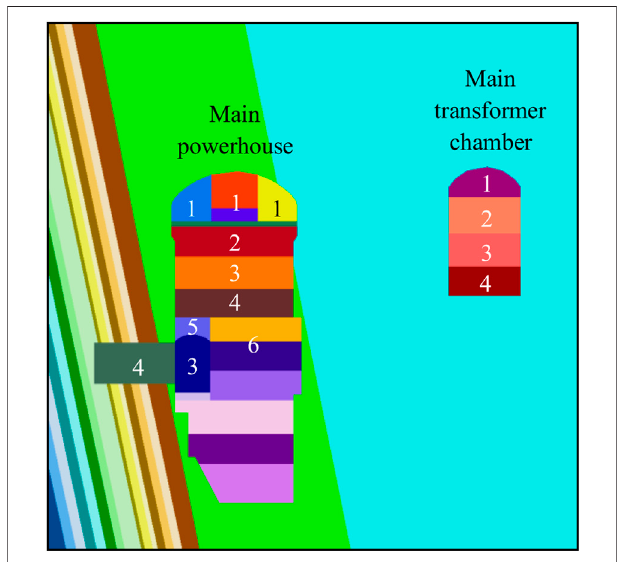
FIGURE 6 | Simulated excavation sequence for the main powerhouse and main transformer chamber.